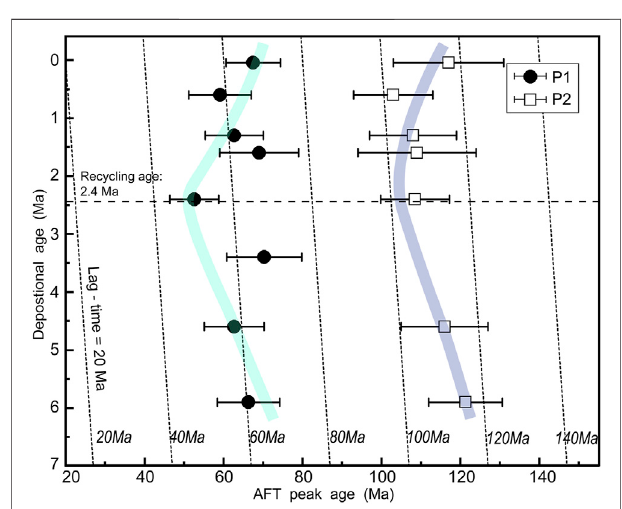
FIGURE 5 | Apatite fi ssion track (AFT) fi tting age peaks versus depositional age plot.